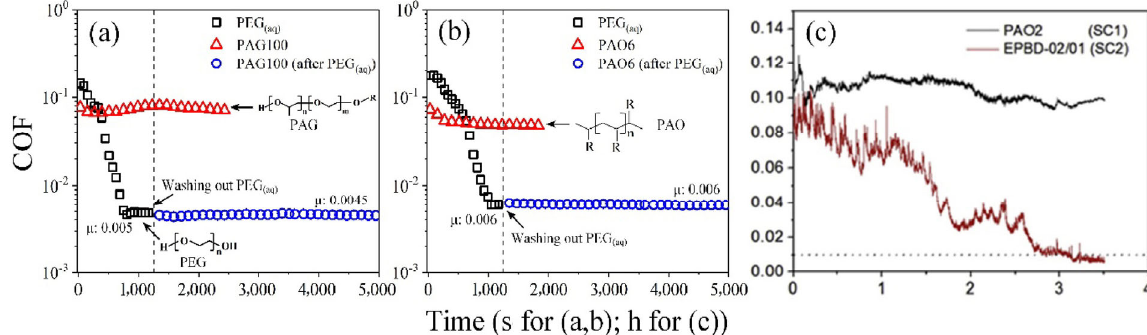
Fig. 8 Friction coefficient of steel surface before and after PEG running-in treatment: (a) PAG, (b) PAO, and (c) 1,3-diketone. (a) and (b) Reproduced with permission from Ref. [78]. © The author(s), 2018. (c) Reproduced with permission from Ref. [79]. © Elsevier, 2018.